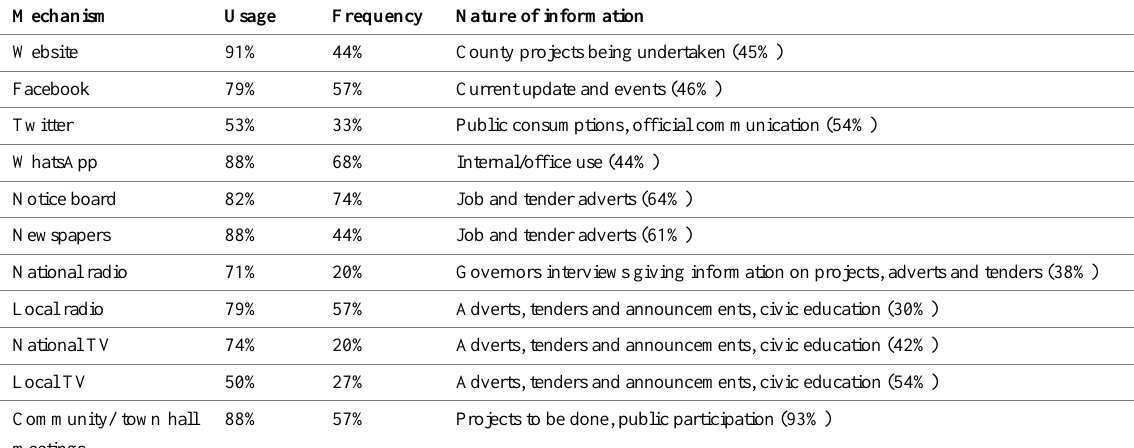
Table 7: Transparency and public participation mechanisms (N=34)